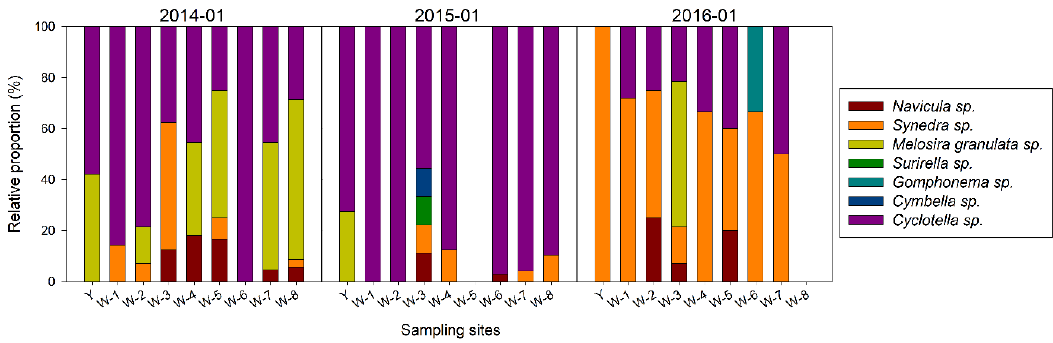
Figure 6. The relative proportions of Bacillariophyta genera in January of different years in the Wangyu River channel.